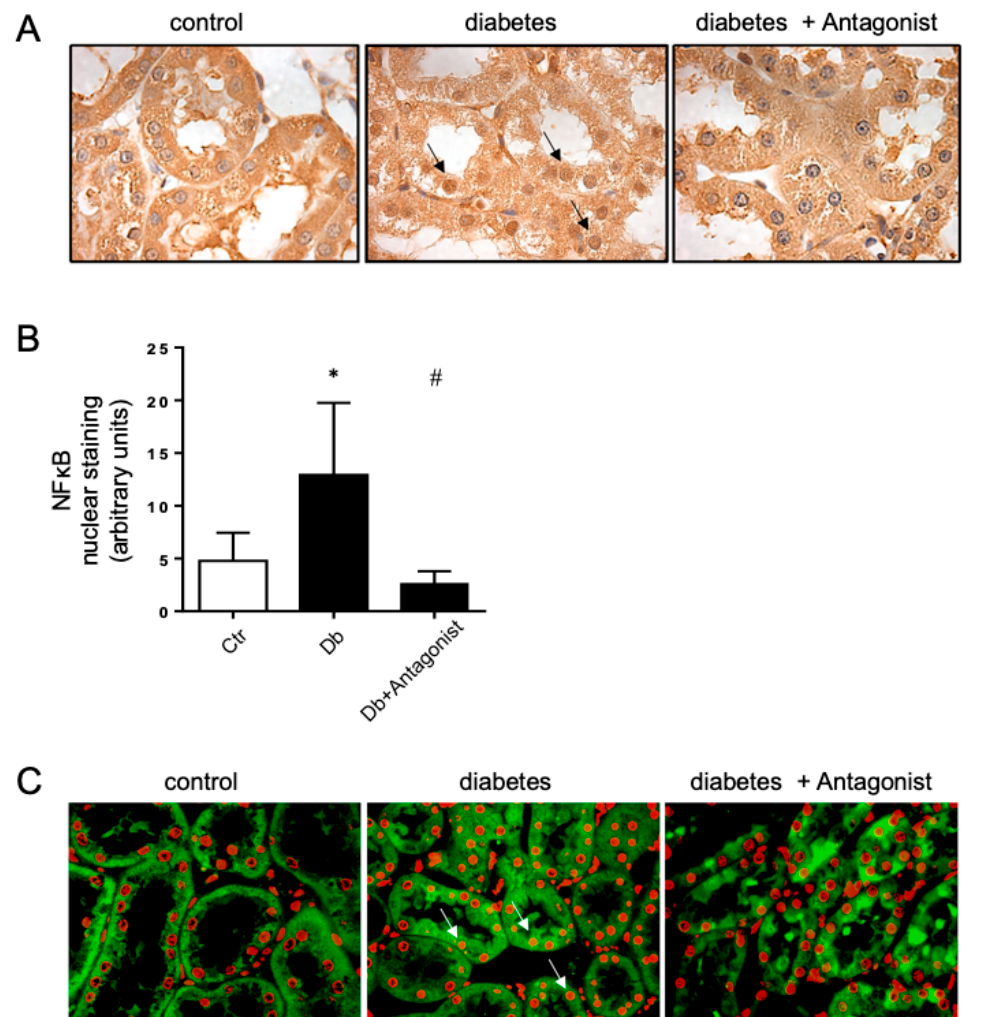
Figure 3. The ADORA3 antagonist decreases nuclear localization of NF- κ B. Analyses of the subcellular distribution of NF- κ B in the kidney cortex were done in renal samples from non-diabetic control rats (Ctr), STZ-induced diabetic rats (Db) and STZ-induced diabetic rats that were treated with ADORA3 antagonist (Db + Antagonist). Representative images of localization of NF- κ B in tubule epithelial cells obtained by peroxidase-coupled immunostaining are shown in ( A ). Arrows indicate positive nuclear staining to NF- κ B. The graph in ( B) depicts the quantitative analysis of nuclear staining of NF- κ B on 10 microscopic fields per slice from animals belonging to each experimental group using UN-SCANIT 2.0 software. n = 5 in each group. *, p < 0.05 vs. control group; # , p < 0.05 vs. Diabetic group. Representative merged images of NF- κ B immunofluorescence (green) and nuclei staining using DAPI (red) in each experimental group are shown in ( C ). Arrows indicate representative colocalization of NF- κ B and nuclear staining. Original magnification 400×.